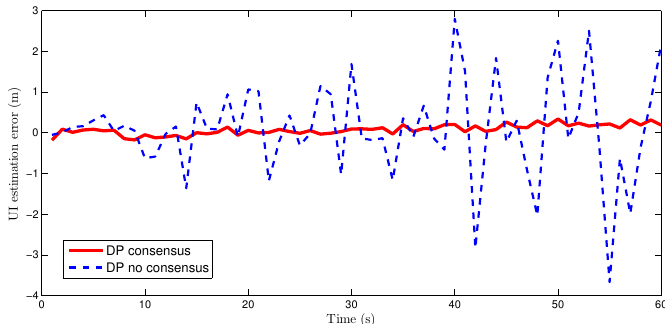
Figure 10. UI estimation errors of the DP consensus and DP no consensus methods for sensor 4.